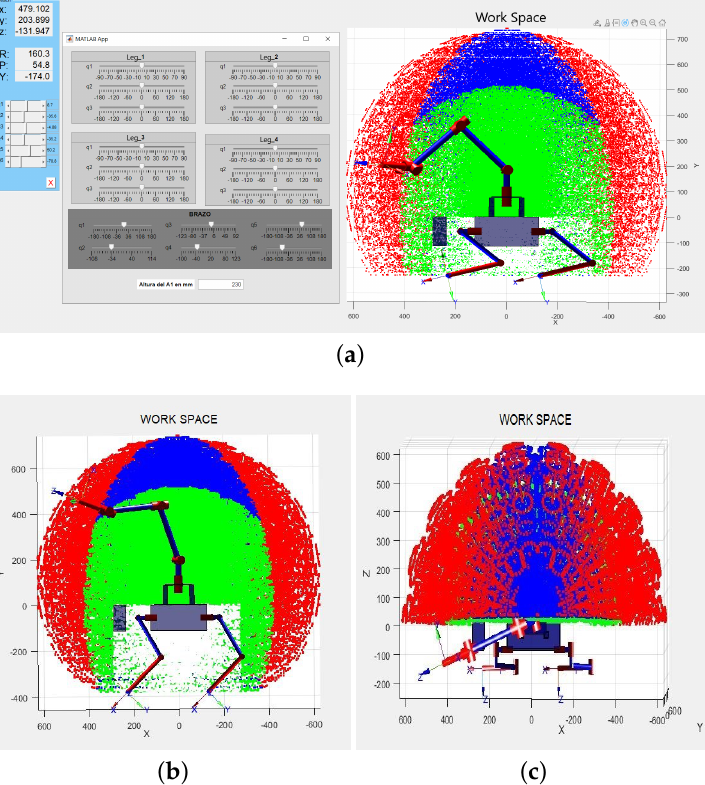
Figure 2. Kinematic Model and Workspace of Robotic Set in Matlab. ( a ) Matlab interface developed for Work Space optimization. The quadruped-manipulator robot is shown in reduced height position. ( b ) Lateral Workspace view of the Model. Reference system is located in the torso center. ( c ) Upper Workspace view of the